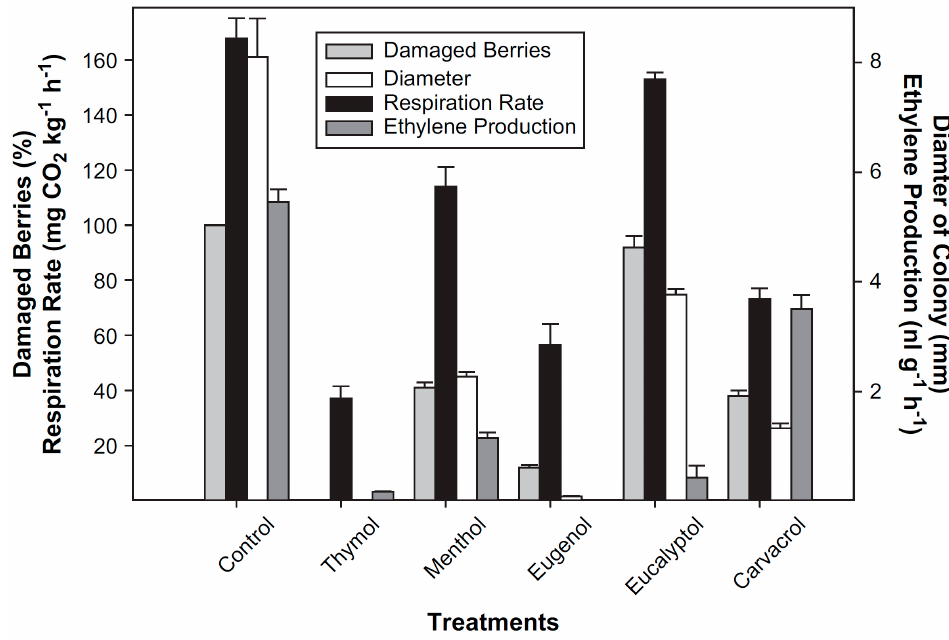
Figure 8. Effect of active packaging with several essential oils vapors concentrations (0.5 mL L − 1 ) in the respiration rate of grapes (expressed as CO 2 production), ethylene production, decay incidence (% damaged berries, and dimension (diameter of colony)) after 4 days at 25 °C (Reprinted with permission from [34], Copyright Elsevier (2008)).